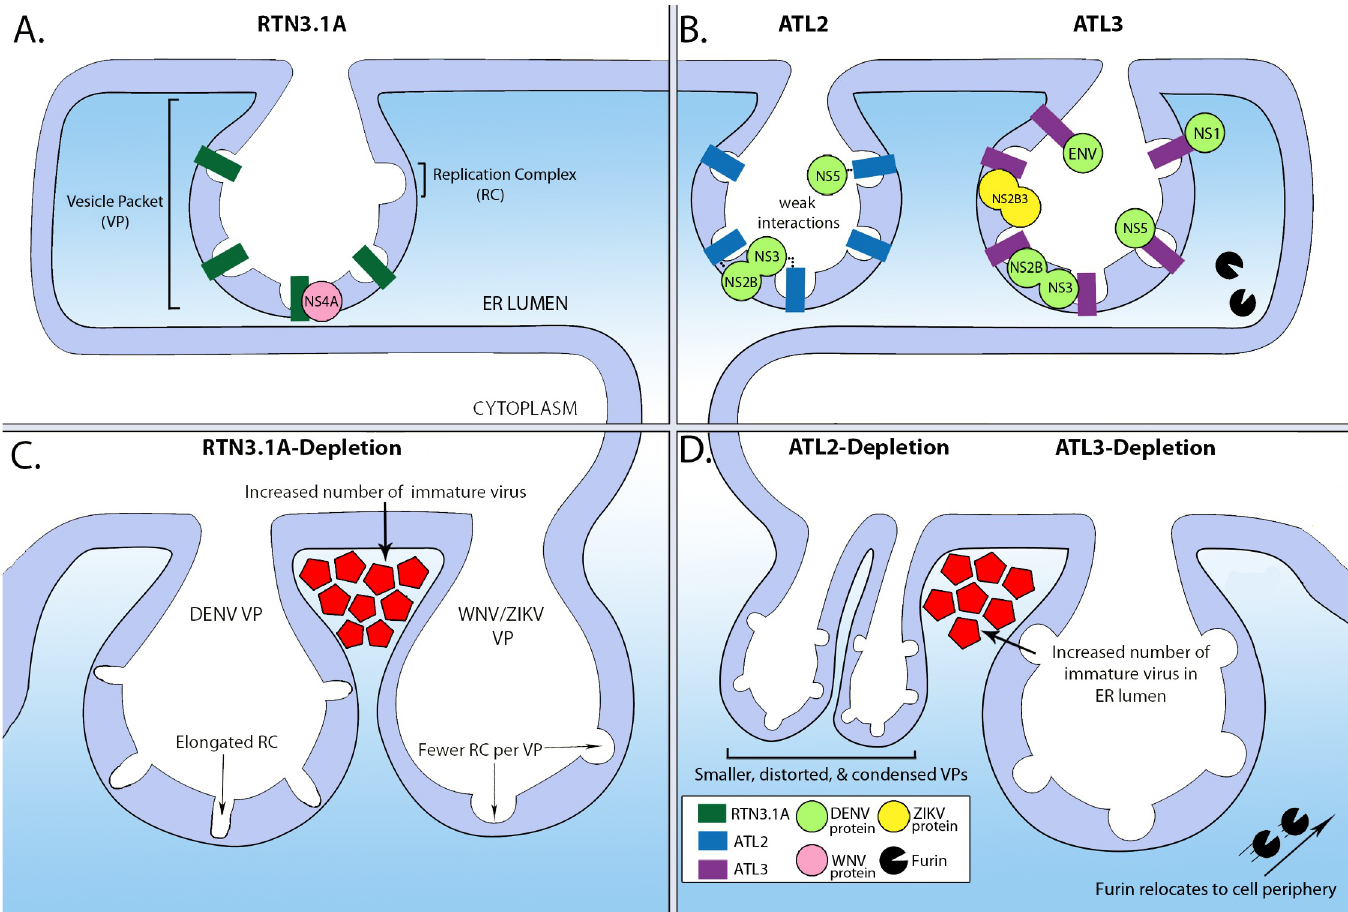
Fig 2. The relationship between ER-shaping proteins and flaviviruses during infection. A simplified schematic showing the interaction between different flavivirus proteins and ER-shaping proteins: (A) RTN3.1A and (B) ATL2 (left) and ATL3 (right). (C) Depleting RTN3.1 results in elongated RCs in DENV-infected cells and fewer RCs per VP in WNV-infected and ZIKV-infected cells. (D) Depleting ATL2 (left) results in VPs that are smaller, distorted, and condensed but does not change the overall number of VPs, whereas ATL3 depletion results in the host-protease Furin relocating from the perinuclear region to the cell periphery and accumulation of immature virus particles in the ER lumen. Immature virus particles are represented smaller than they would be in relation to VPs. ATL2, Atlastin-2; ATL3, Atlastin-3; DENV, dengue virus; ENV, envelope; ER, endoplasmic reticulum; NS1, nonstructural protein 1; RC, replication complex; RTN3.1A, Reticulon 3.1A; VP, vesicle packet; WNV, West Nile virus; ZIKV, Zika